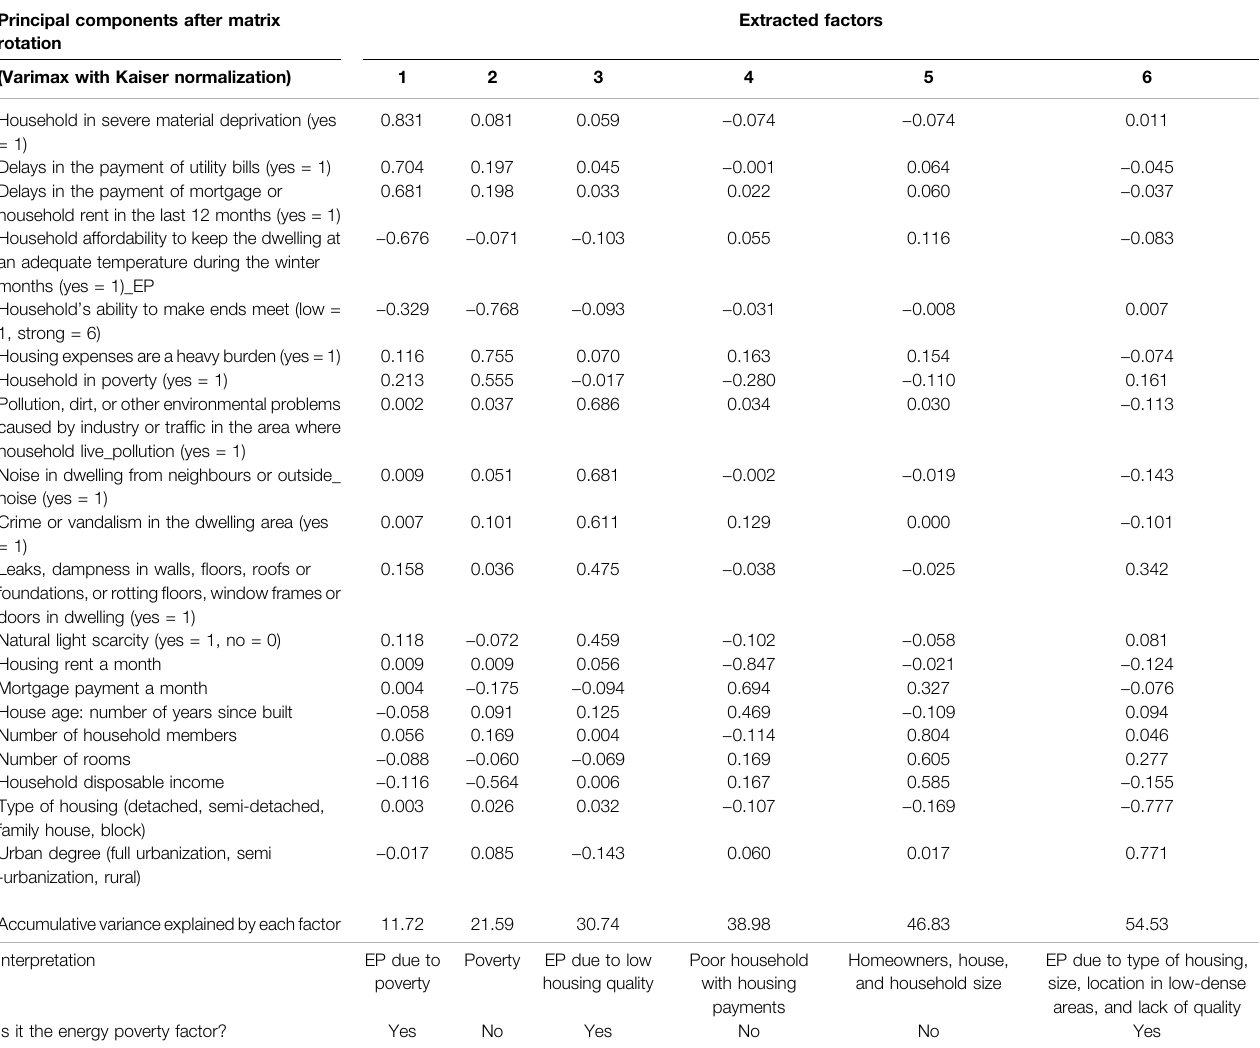
TABLE 2 | Energy poverty factors